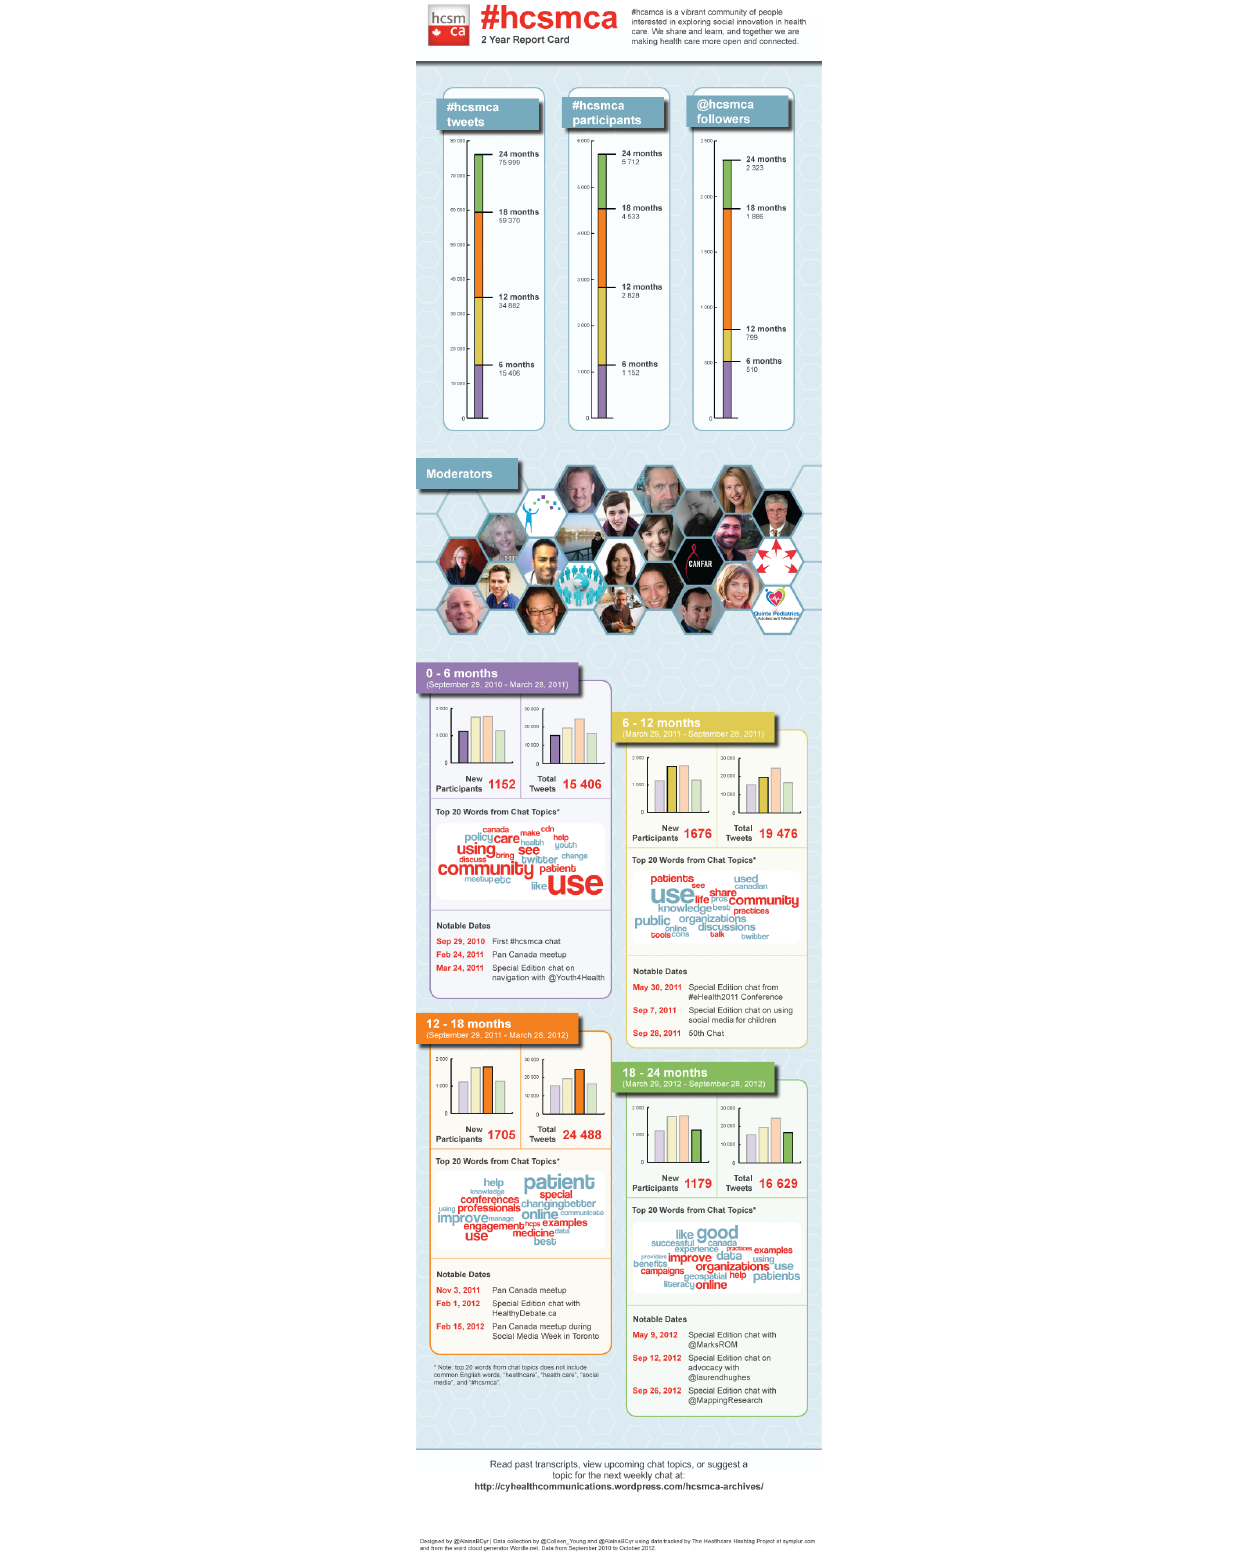
Figure 5. Infographic created by a hcsmca community member about the